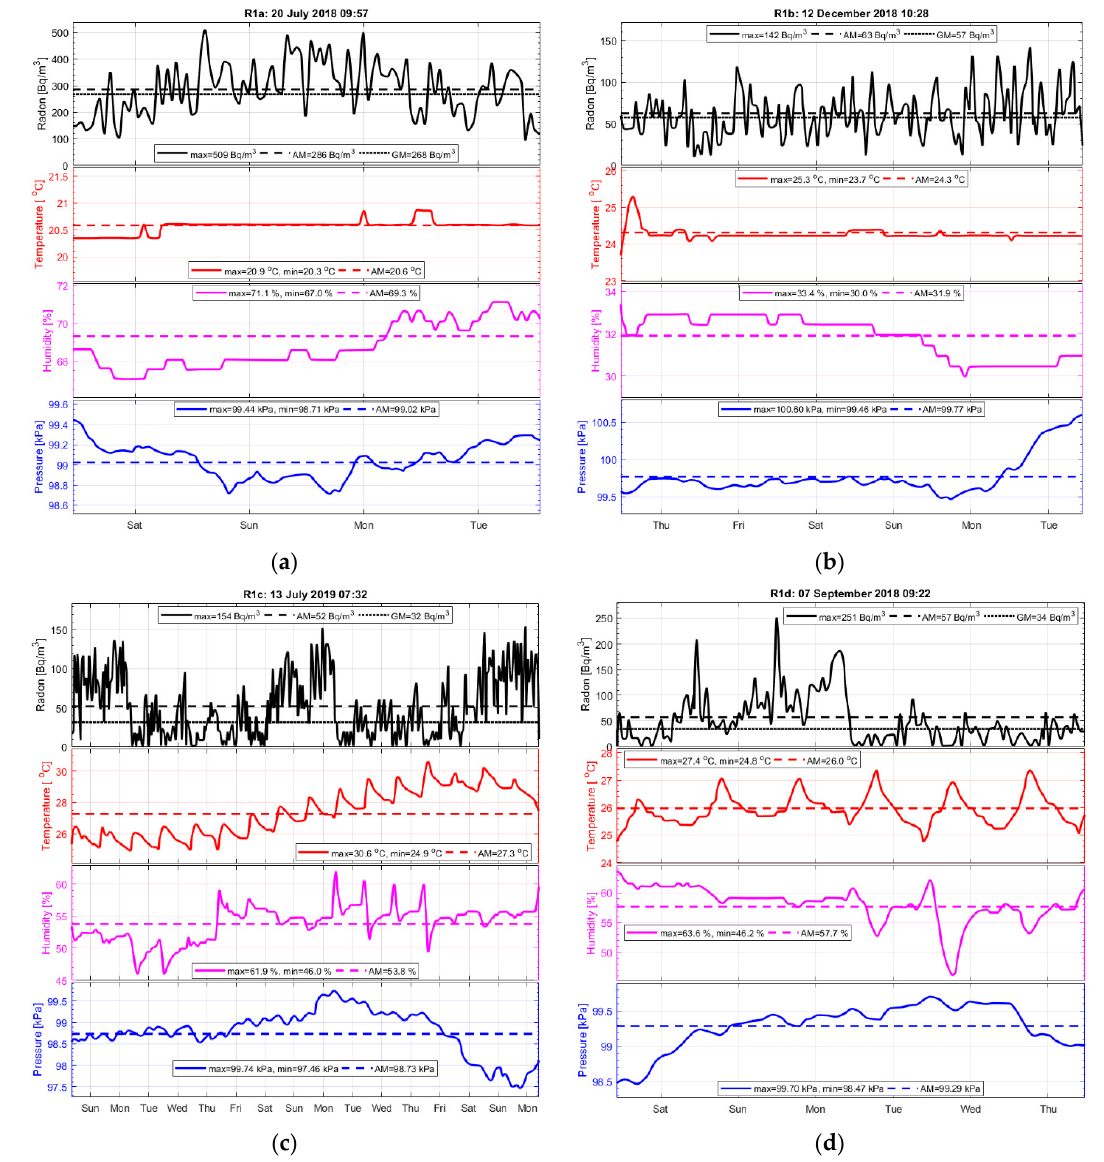
Figure 2. Radon measurements in office building (R1). (a) Basement-storage, ( b ) basement-laboratory, ( c ) office on 1 st floor, ( d ) office on 3 rd floor. For each floor, 4 sublots are shown within time and days of measurements: radon concentrations, indoor temperature, humidity and air pressure with arithmetic mean and geometric mean values shown in legend. Day tick marks 00:00 time.